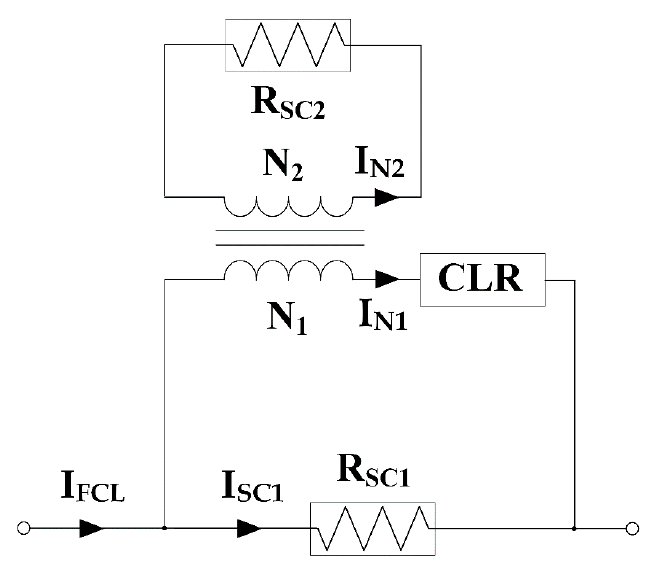
Figure 2. Configuration of DC SFCL using a transformer.